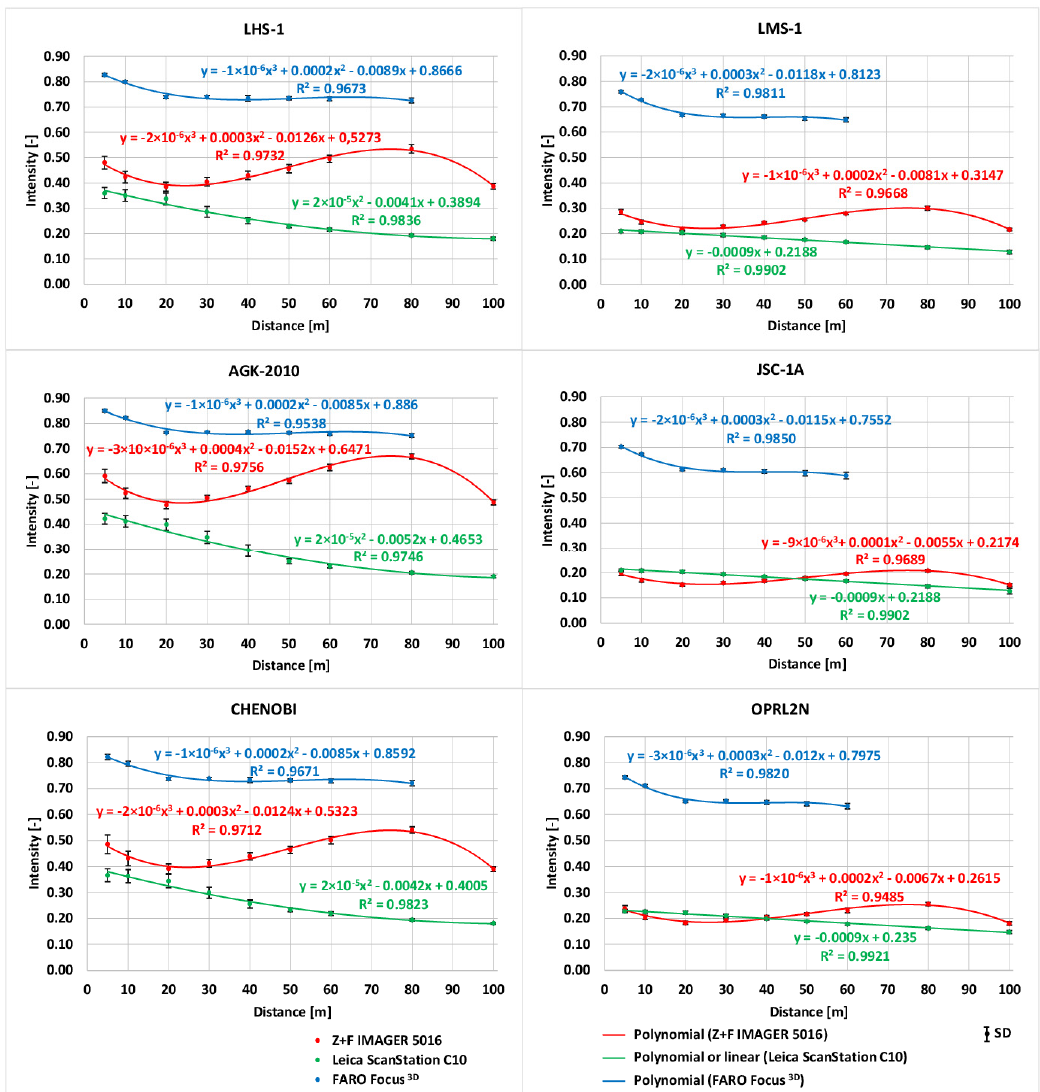
Figure 6. Relationship between the intensity and distance for different LSS specimens. It is clear that the intensity values registered by the FARO Focus 3D are significantly higher than those registered by the Leica ScanStation C10 and Z+F IMAGER 5016. Never ‐ theless, some of the scans of the LSS specimens at distances of 80 and 100 m were not registered by the FARO Focus 3D scanner. It should be noted that this scanner had the short ‐ est measuring distance of up to 120 m (see Table 2). For all of the LSS specimens scanned with the Leica ScanStation C10, the decrease in the intensity value is directly proportional to the increase in the measuring distance. This relationship can easily be described using a linear or quadratic polynomial function. In the case of the Z+F IMAGER 5016, the inten ‐ sity value gradually decreases proportionally to the increase in the measuring distance, reaching minimum values at a distance of 20 m. For longer distances, the intensity value gradually increases proportionally to the increase in the measuring distance, reaching its peak at a distance of 80 m. The intensity values at a distance of 100 m are significantly lower than those obtained at 80 m. In the authors’ opinion, the scanner reached its regis ‐ tration capabilities at this distance. This relationship can be described using a cubic poly ‐ nomial function. It is clear that the intensity values are much higher for LSS specimens that